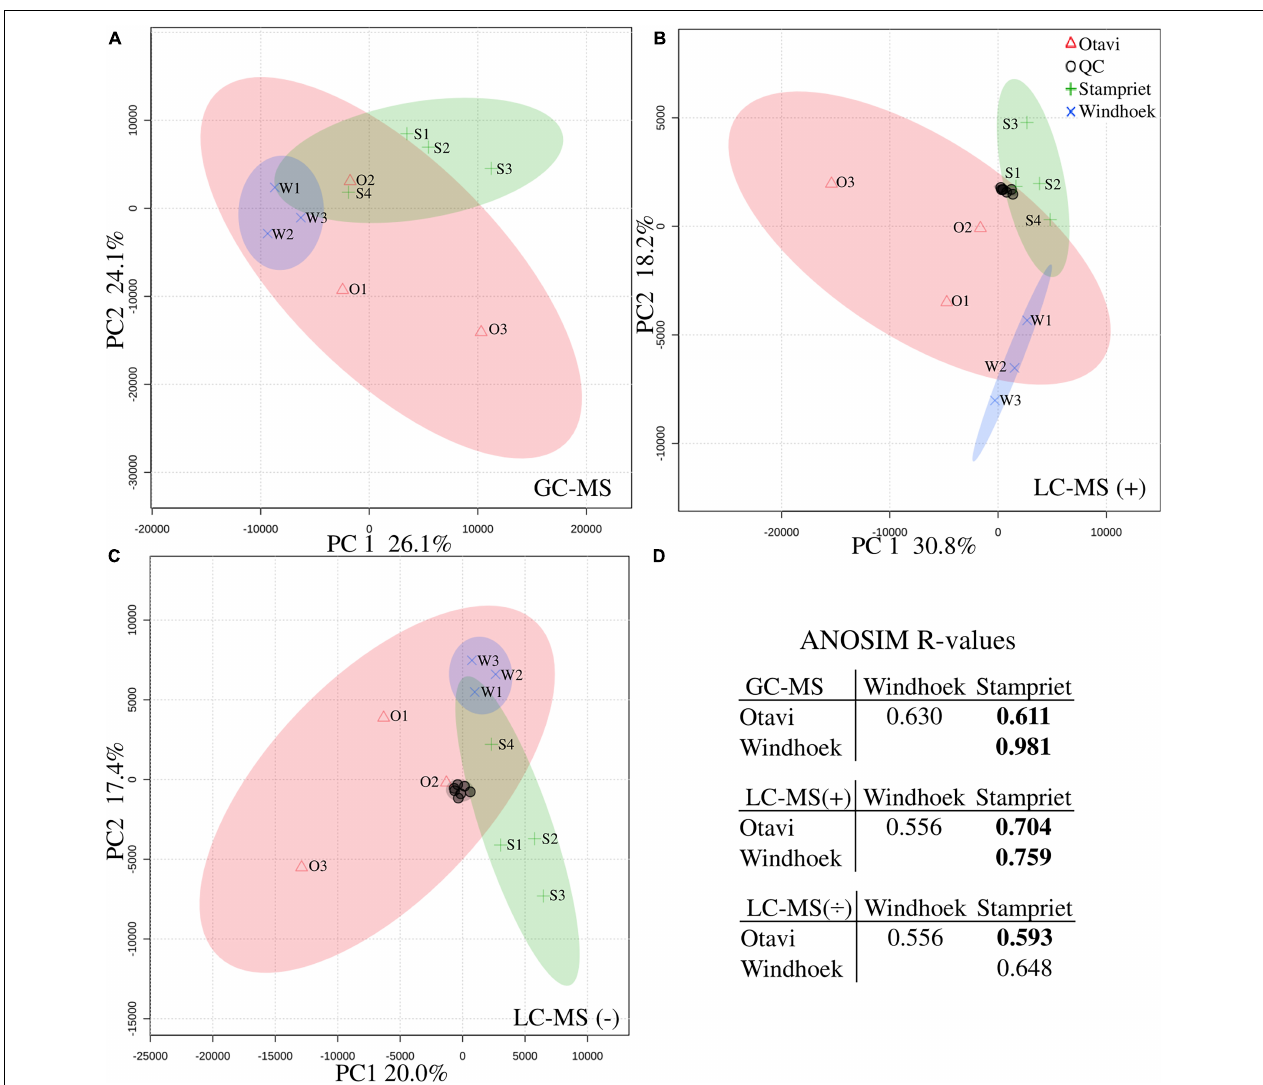
FIGURE 3 | Principle component analysis (PCA) (A–C) and analysis of similarities (ANOSIM) (D) of metabolite profiling data. PCAs are based on normalized metabolite data (average relative abundance): (A) GC-MS data, (B) LC-MS positive mode, and (C) LC-MS negative mode. Populations are depicted with symbols and colors (Otavi, red triangles; Stampriet, green pluses; Windhoek, blue crosses) and 95%-confidence-intervals are indicated by the colored areas of the respective population. Individual samples are named according to population and nest number (see Supplementary Table 1 ). Quality control samples (QC) for LC-MS are depicted with black circles. (D) ANOSIM R-values are based on Bray-Curtis dissimilarities calculated on average relative abundance metabolite data (from top to bottom: GC-MS data, LC-MS positive mode, and LC-MS negative mode). R = 0 indicates no difference in metabolite composition between populations, and R = 1 indicates a high degree of difference. Bold numbers indicate significant difference between populations ( p <